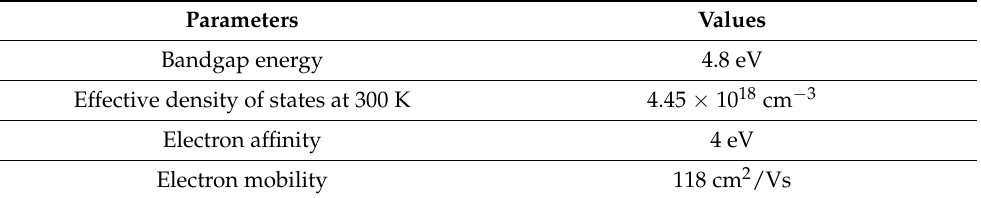
Figure 1. Modelling UWBG semiconductor switches.